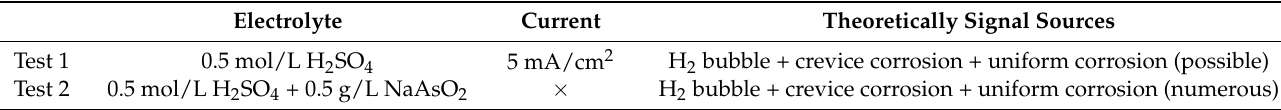
Table 2. Details of two short-time